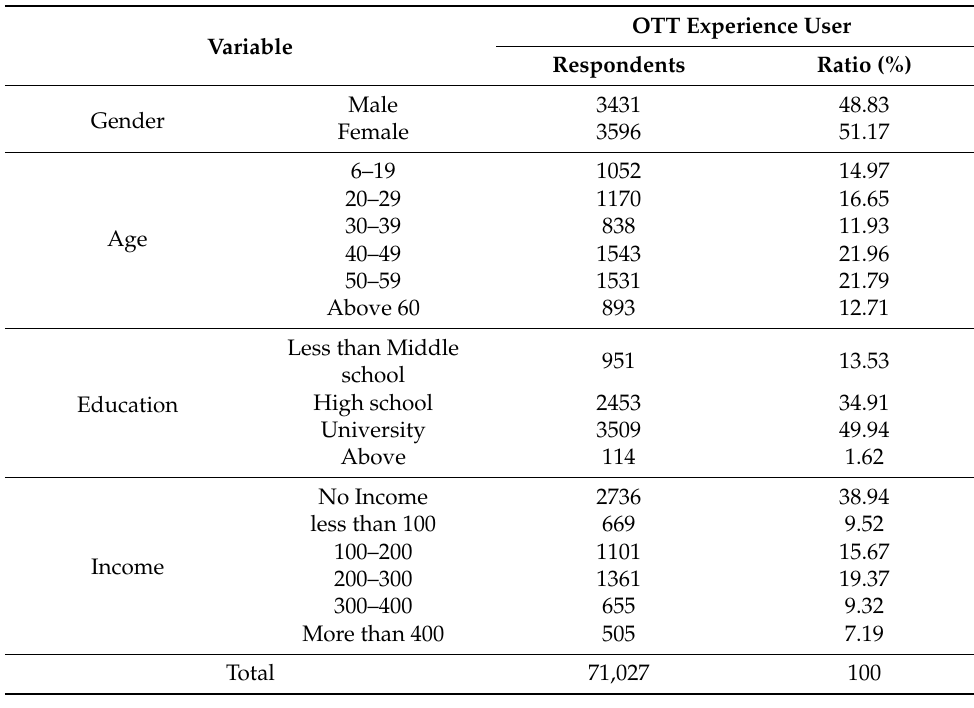
Table 1. Sociodemographic characteristics.